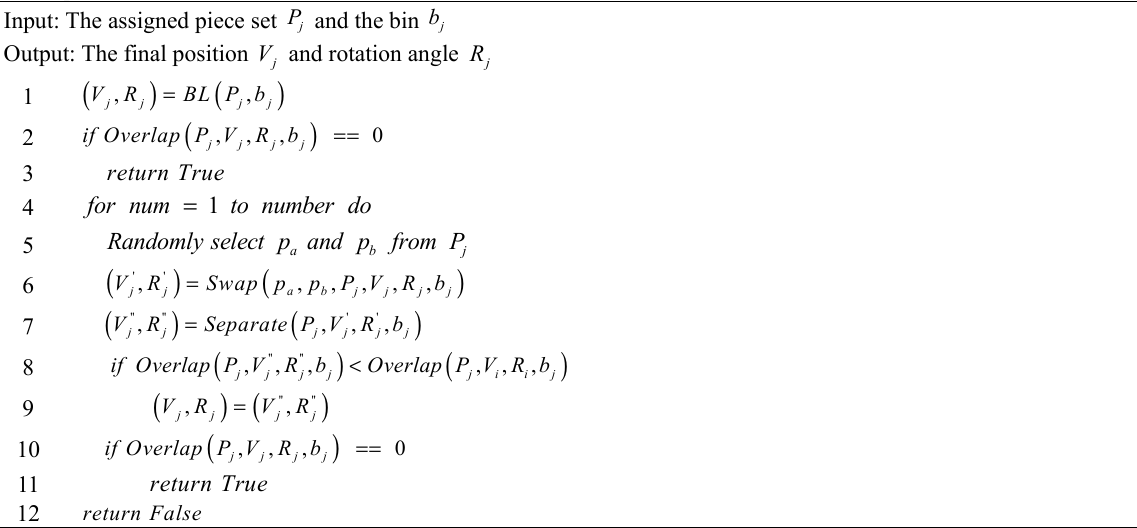
Algorithm 2: Pack the pieces in the piece set of the pieces